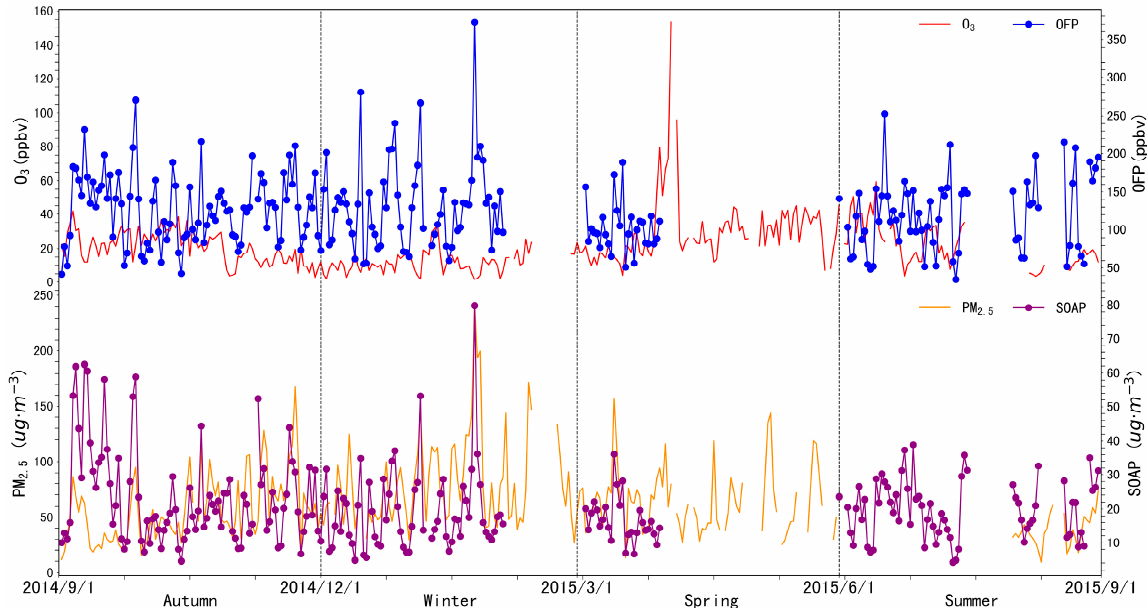
Figure 12. The concentrations of O 3 and PM 2.5 and OFP and SOAP that were estimated at the sampling site.